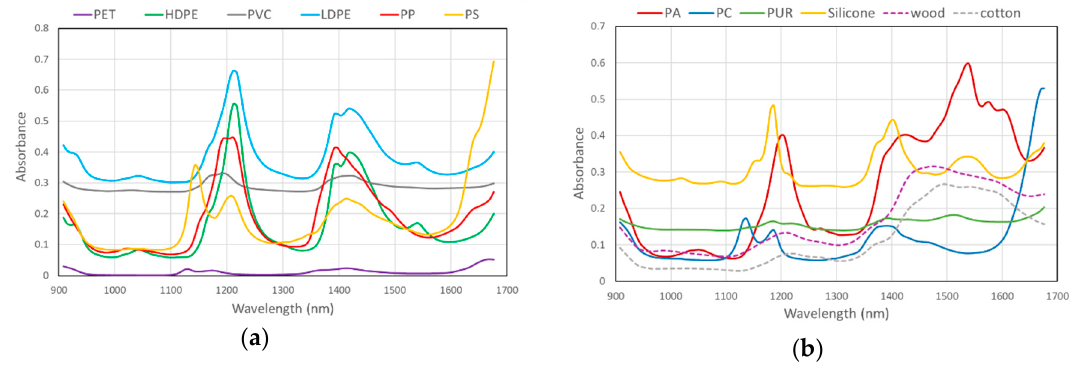
Figure 5. Raw spectra of polymers with RIC 1–6 ( a ) and polymers with RIC 7 together with wood and cotton spectra ( b ).